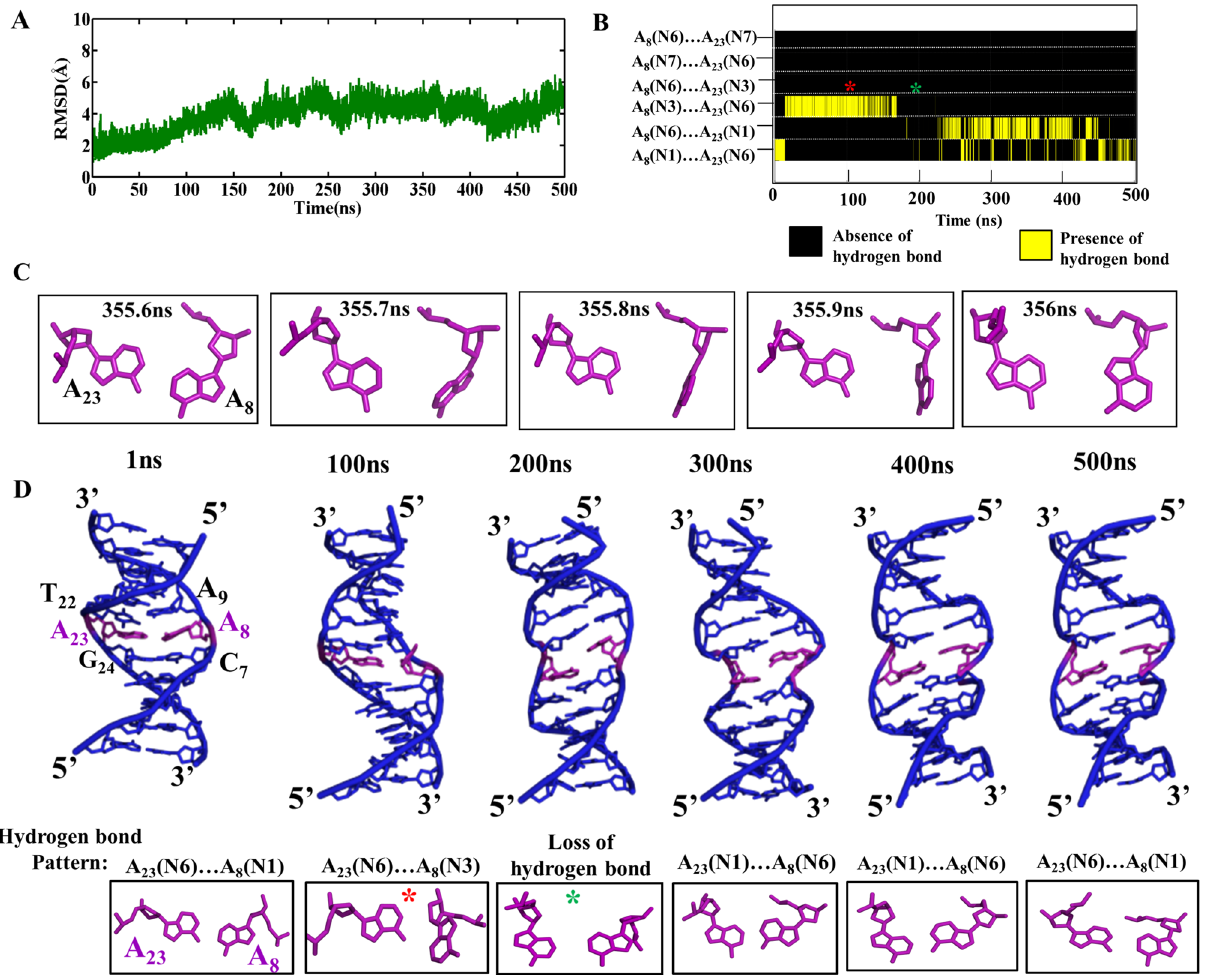
Figure 1. A 8 …A 23 mismatch with anti…anti starting glycosyl conformation induces B–Z junction in the DNA duplex (Scheme DCA-1, Table 1). ( A ) Time vs RMSD profile. The MATLAB 7.11.0 software (www.mathw orks. com) was used to plot the data. ( B ) A 8 …A 23 hydrogen bond lifetime profile. The possible hydrogen bonding patterns between A 8 and A 23 are indicated in the Y-axis. Note that the red and green colored stars are associated with the transient events represented in ( D ). The GNUPLOT 5.2 software was used to plot the data 54 . ( C ) Transient flipping of A 8 observed around 356 ns. ( D ) Cartoon representation of the conformational dynamics (top) and the concomitant A 8 …A 23 hydrogen bond dynamics (boxed, bottom). The figures ( C ) and ( D ) were generated by using Pymol 1.3 (www.pymol .com) software 53